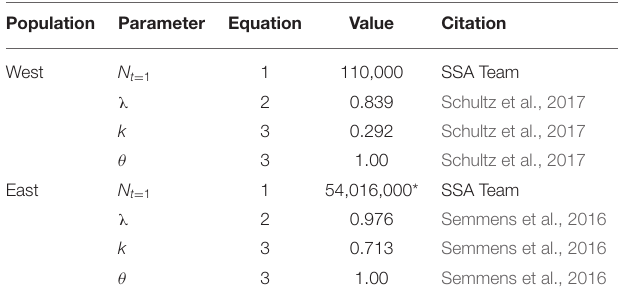
TABLE 1 | Model parameters used to project monarch populations with the log-scale geometric growth model. Population Parameter